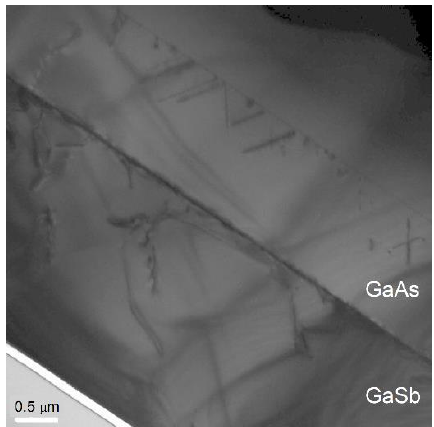
Figure 5. TEM cross section of #012 GaSb / GaAs heterostructure: the thicker region (lower part of the image) corresponds to the GaSb material. TDD is 5.6 × 10 9 cm −2 .